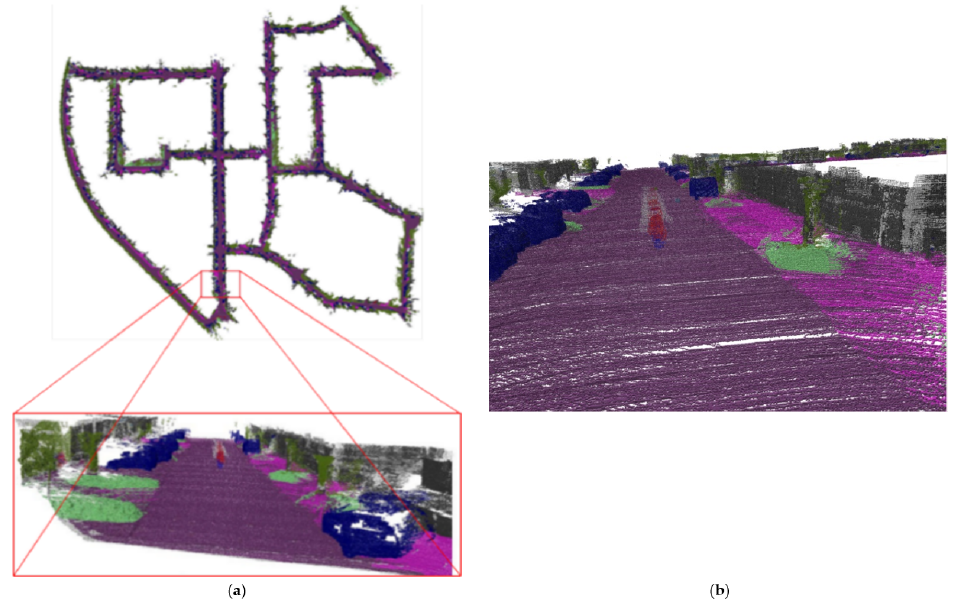
Figure 11. Semantic reconstruction of sequence 00 and local details: ( a ) The complete semantic reconstruction of sequence 00. ( b ) The magnified local details of semantic